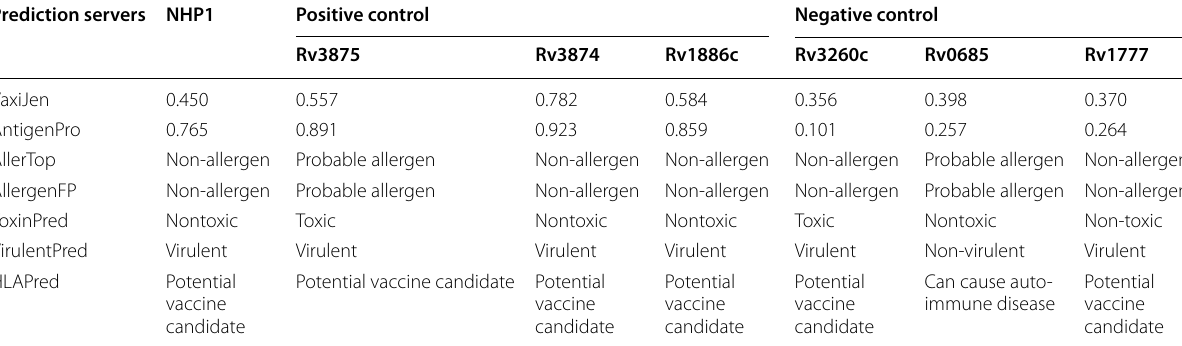
Table 2 Comparison of the immunological properties of NHP1 protein with positive and negative controls Prediction servers NHP1